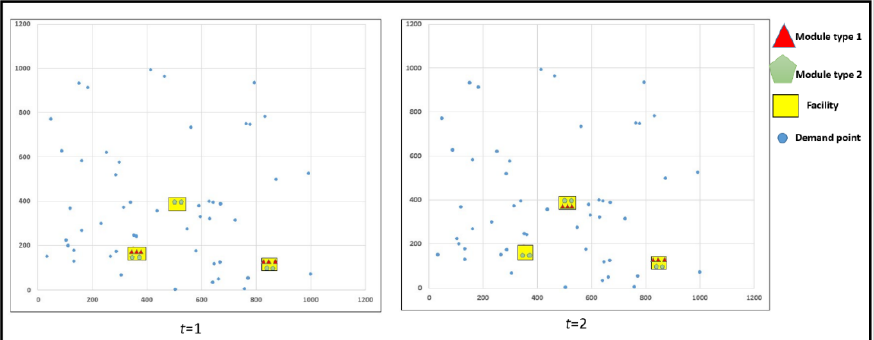
Figure 1. Illustrative example to depict the modules assignment and facilities location.